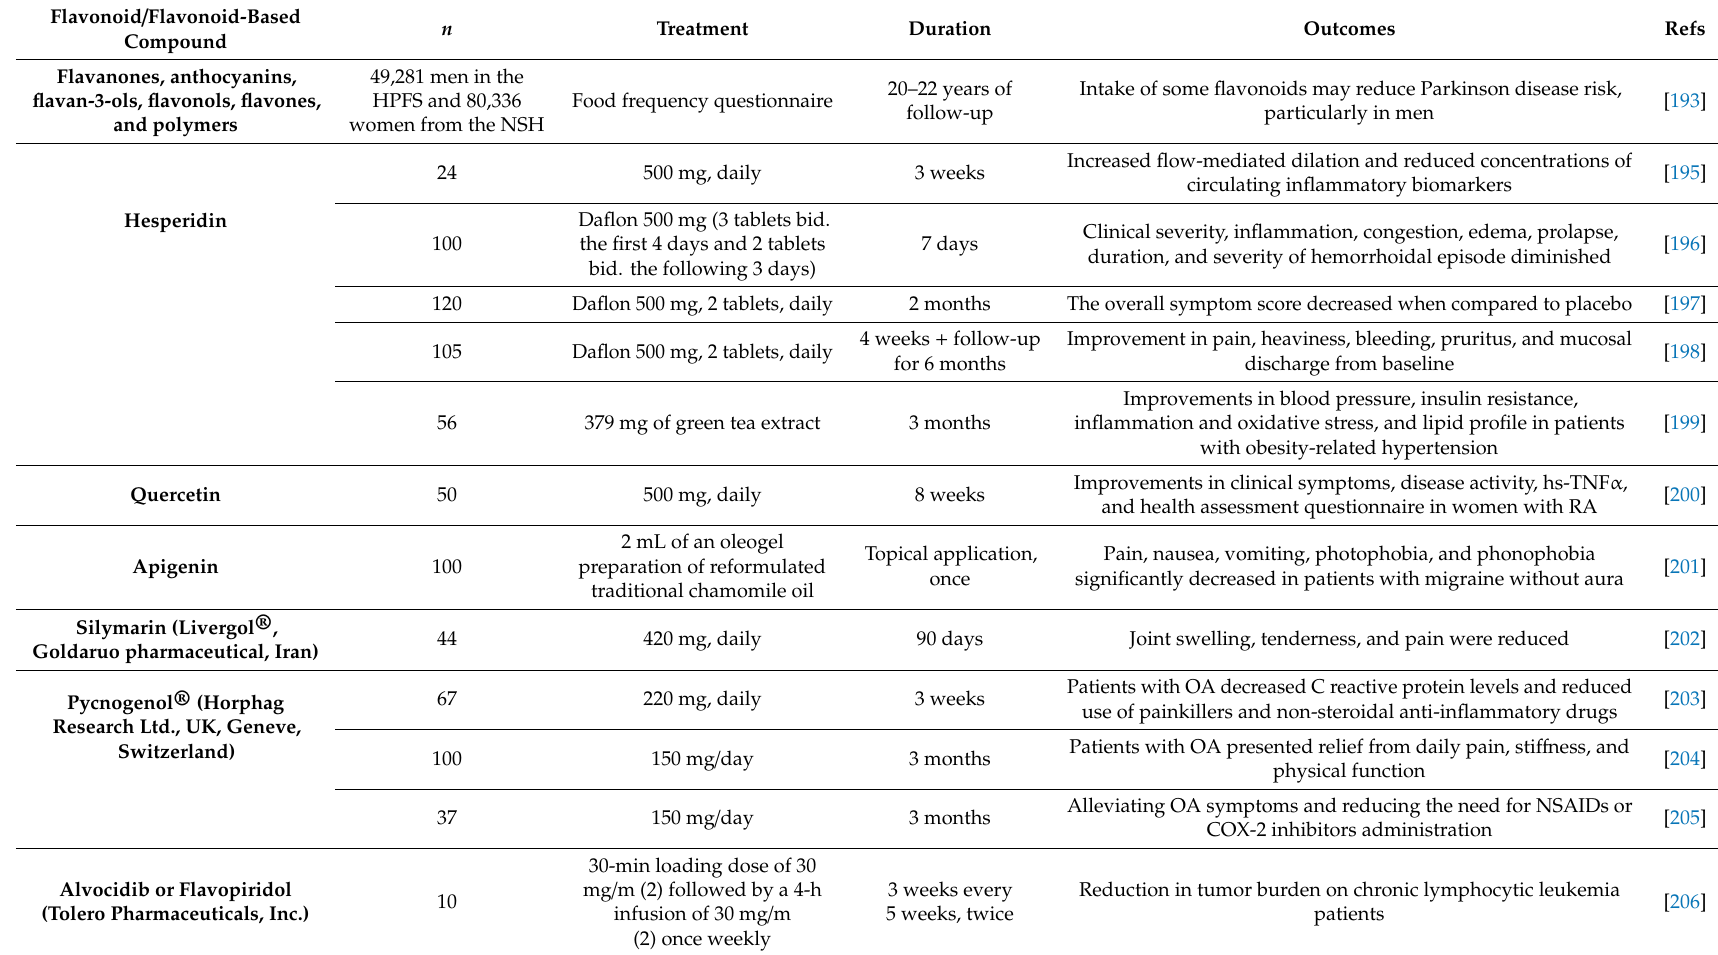
Table 2. Clinical studies analyzing the e ff ects of di ff erent flavonoids in diets or as supplements in